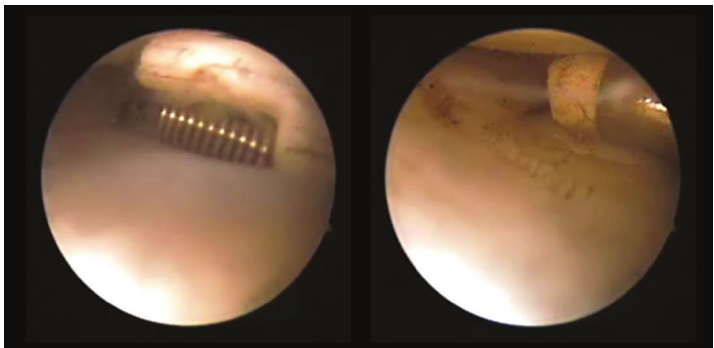
Figure 1: Arthroscopy of both knees was performed, followed by arthroscopic partial meniscectomy with a high-frequency electric knife for both knees.